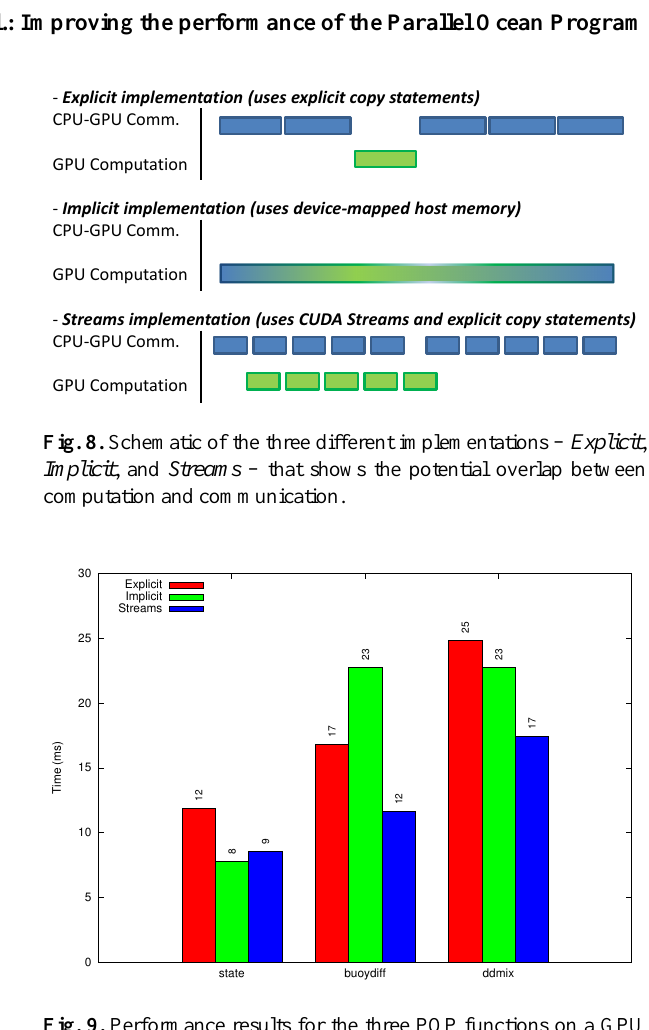
with three different implementations as obtained on the Tesla K20 obtained on the Tesla K20 GPU with a 229 × 304 block size.